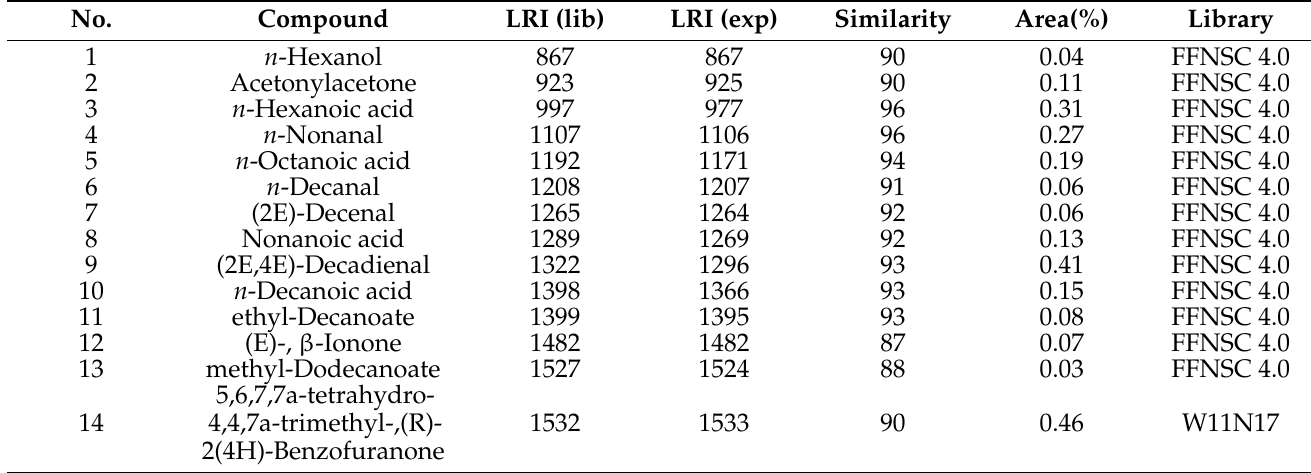
Figure 1. GC – MS profile of the n -hexane fraction of C. humilis. Main peaks are labeled. Peak assignment as in Table 4. Table 4. List of compounds identified in the n -hexane fraction of C. humilis by GC – MS.